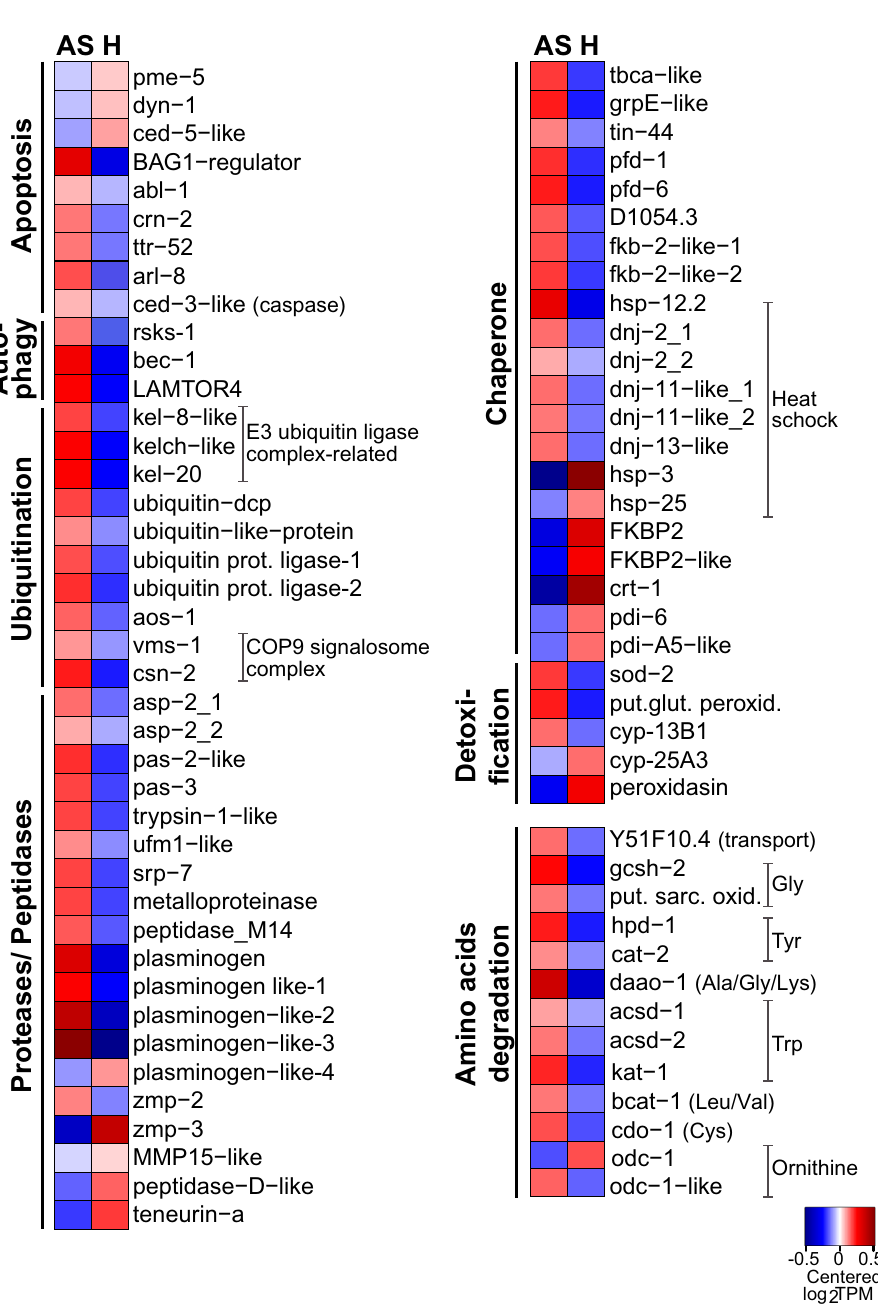
Figure 3. Genes involved in detoxification, ubiquitin–proteasome, autophagy, apoptosis, and amino acids degradation were predominantly expressed in AS worms. Heatmap displaying genes upregulated in AS (anoxic sulfidic) relative to H (hypoxic) worms after 24 h-long incubations under one of the two conditions (1.5- fold change, FDR ≤ 0.05). Expression levels are displayed as mean-centered log 2 TPM value (transcripts per kilobase million). Genes are ordered by function in their respective metabolic pathways. For each process, the minority of genes that were upregulated in H worms is shown in Data S1. Red denotes upregulation, and blue downregulation. Prot. protein, COP9: Constitutive photomorphogenesis 9. dcp: domain-containing proteins; Put. glut. peroxid.: putative glutamate peroxidase; Put. sarc. oxid.: putative sarcosine